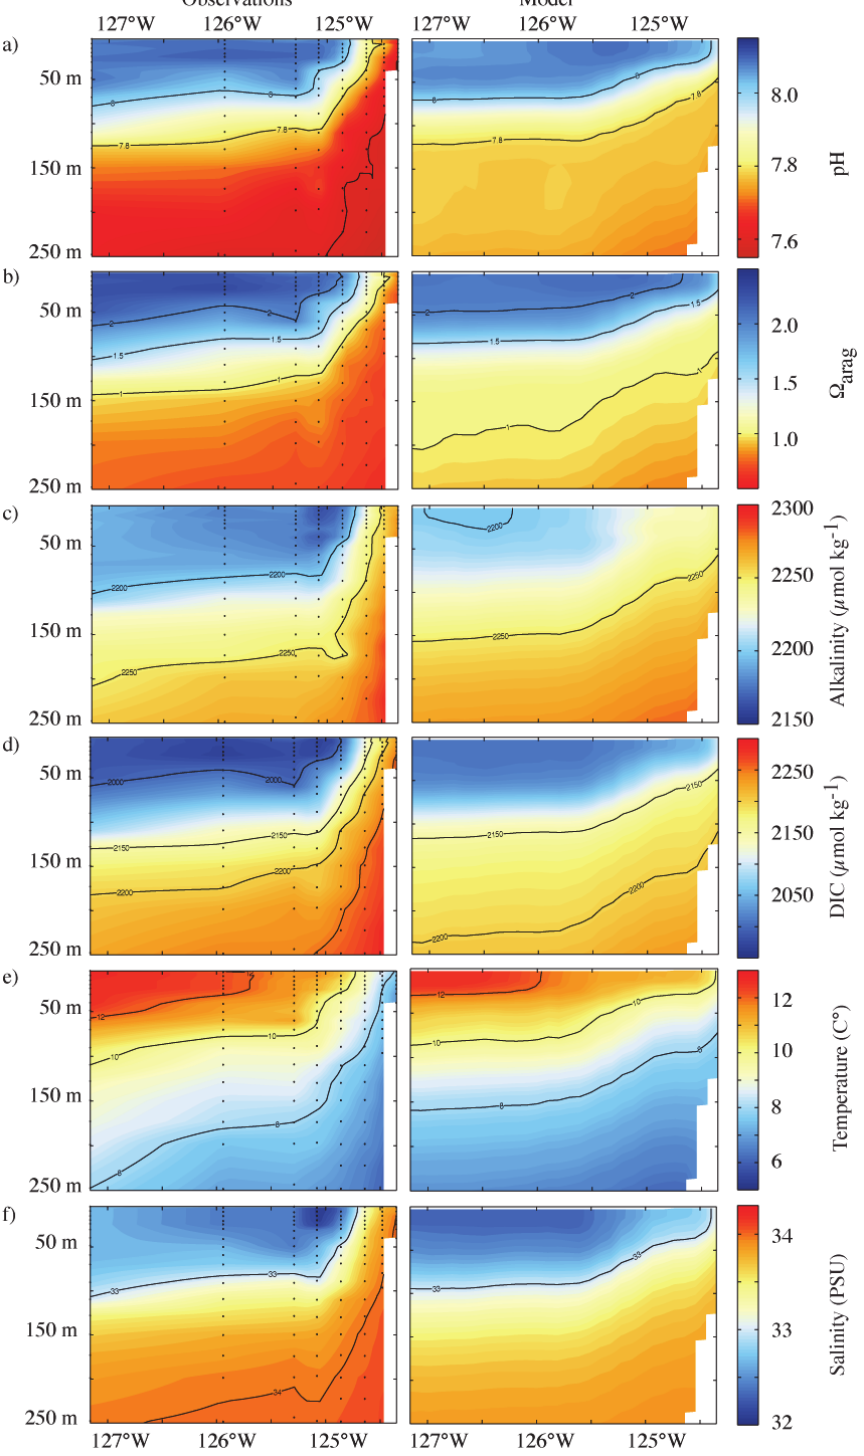
Fig. 4. Vertical sections of (a) pH, (b) (cid:127) arag , (c) alkalinity, (d) DIC, (e) temperature and (f) salinity of observations (left, Feely et al., 2008) and the corresponding model output (right), off Pt. St. George, California. A five-year average of model parameters over May and June (2006–2010) is compared to observations sampled between May and June 2007. The black dots represent sample locations. 31